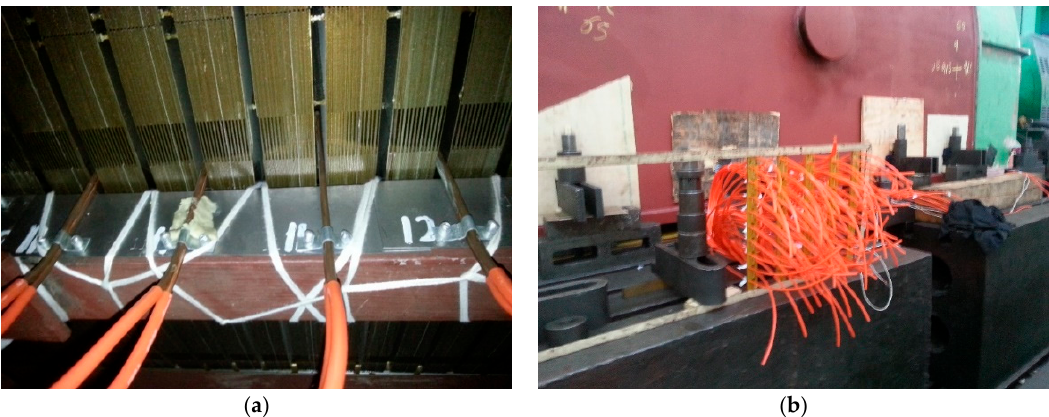
Figure 2. Placement and measuring position of pitot tube in the stator ventilation ducts. ( a ) Placement position of pitot tube; ( b ) measuring position of ventilation duct.